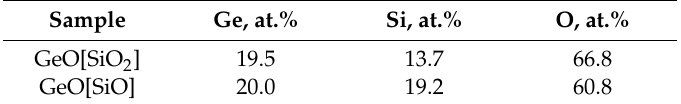
Table 1. The near-surface composition of the studied samples in atomic percents. Sample Ge, at.% Si, at.% O,